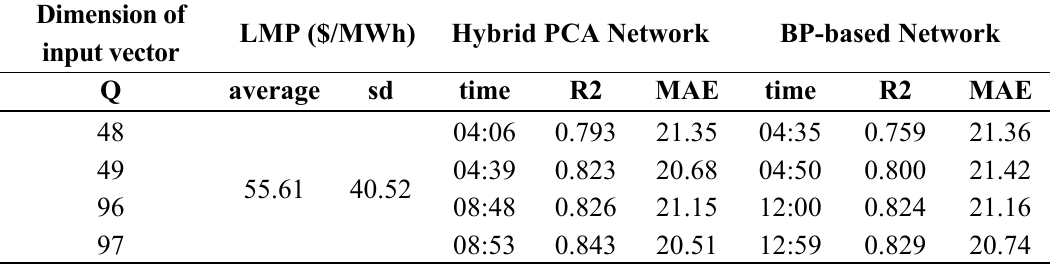
Table 2. Performance comparison between the proposed hybrid PCA and BP-based neural network (Fisk, summer).